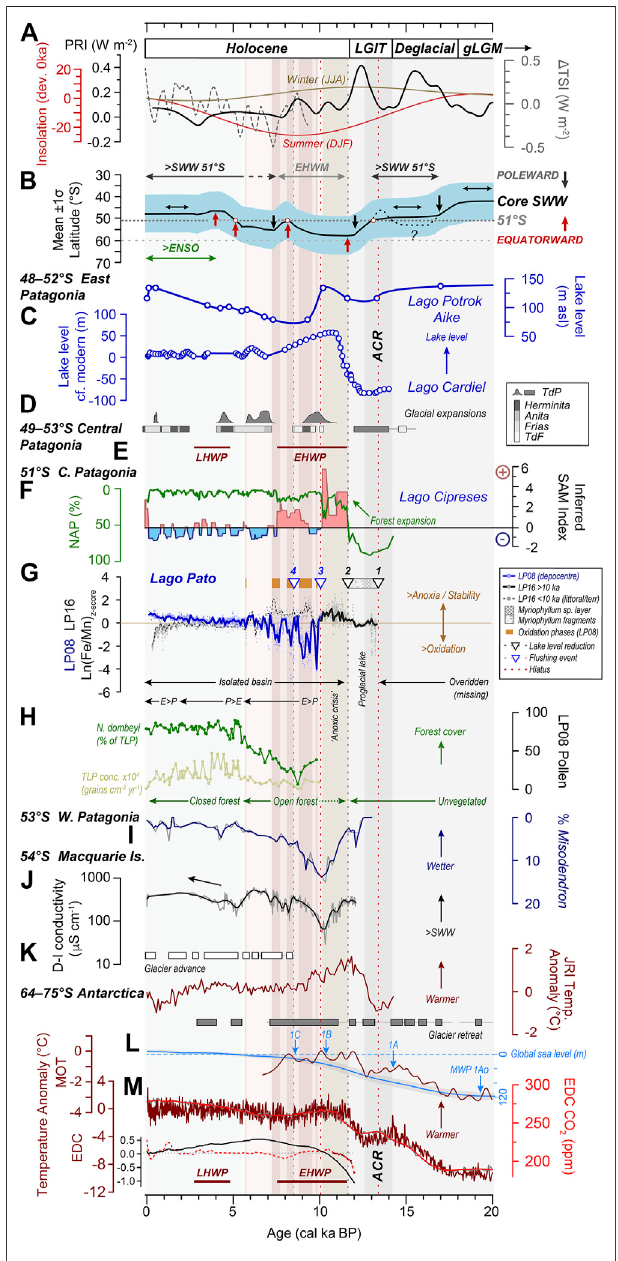
FIGURE 10 | Regional-global driving mechanisms of glacier dynamics andpalaeoclimaticchangecompared withlake-levelchangeinPatagoniaand the Fe/Mn (redox) record from Lago Pato over the last 20 cal ka BP. (A) Total Solar Irradiance deviation ( Δ TSI, dashed grey line) from present-day value (a solar forcing parameter based on variations in 10 Be isotope data from ice cores) (Steinhilber et al., 2009), austral winter insolation (June – July – August, JJA; brown line), and summer insolation (December – January – February, DJF; red line) at 51 ° S (Laskar et al., 2004); the planetary radiative imbalance at the top of the atmosphere (PRI, solid black line). This is the principal driver of global climate change, de fi ned as the difference between the total insolation absorbed at the top of the atmosphere and the amount of energy radiated back into space (Baggenstos et al., 2019). (B) Hypothetical representation of the mean annual latitudinal position of the ( Continued